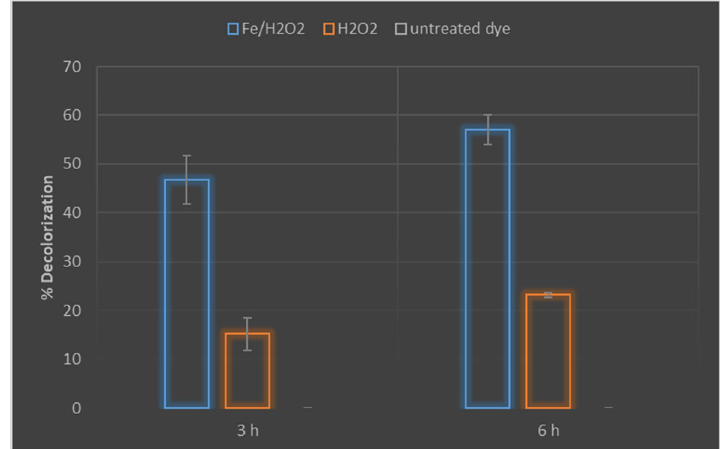
Figure 20. Methylene blue decolorization ability of biosynthesized iron nanoparticles.